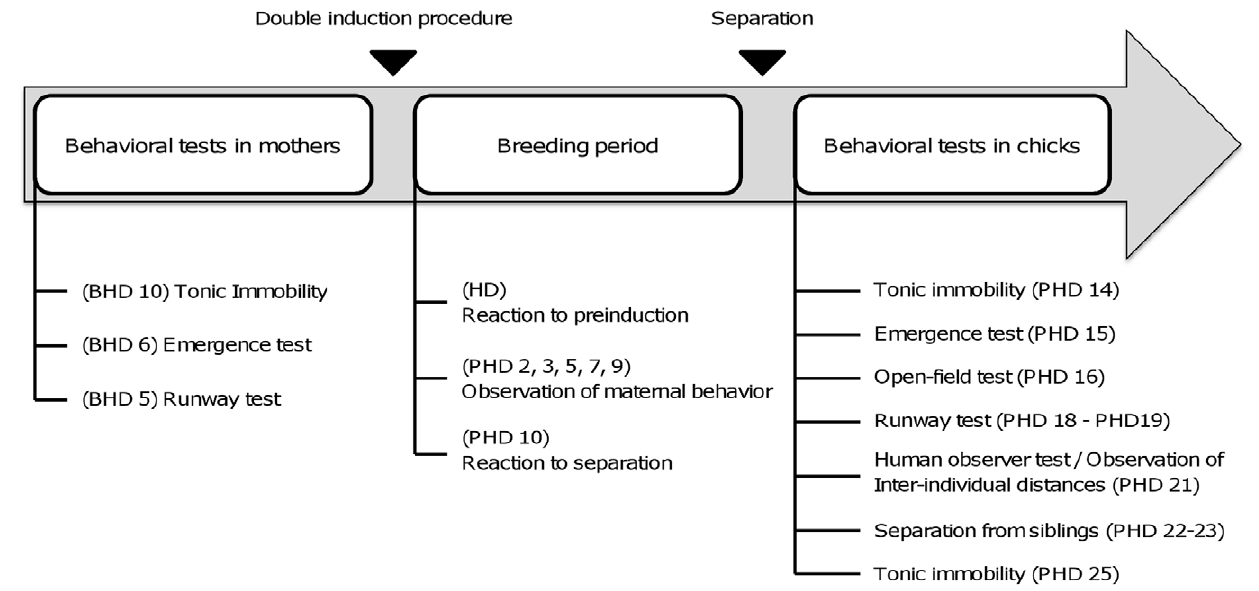
Figure 1. Experimental schedule. Test and observation schedule. Dates refer to hatching day of test chicks; (BHD: before hatching day, HD: Hatching day, PHD: post-hatching day).